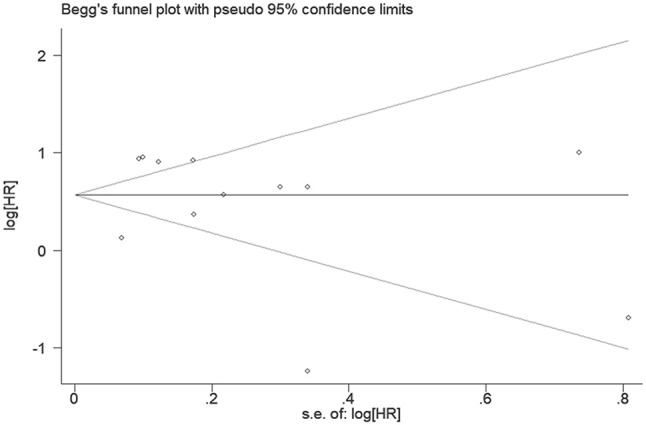
Funnel plots of included studies in the analysis of NNMT expression and the prognosis for solid tumors.